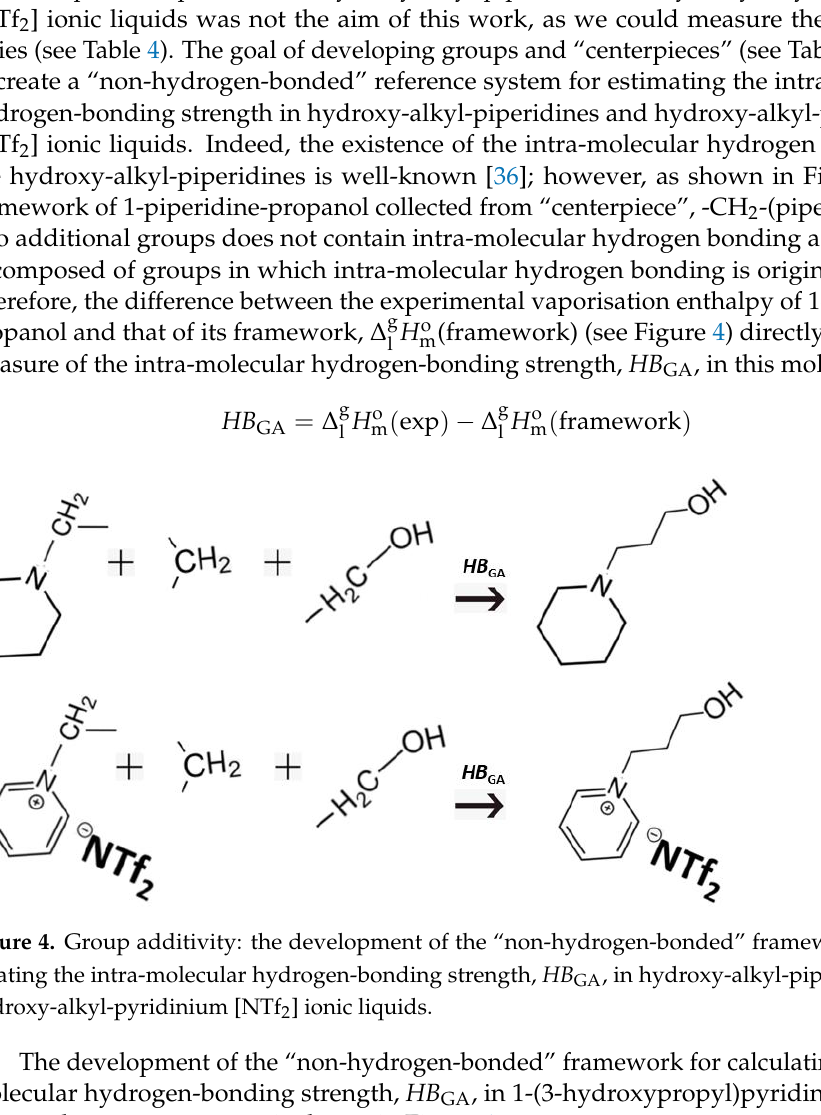
Figure 5. Well-balanced equations: the development of the “non -hydrogen- bonded” reference sys- tems for calculating the intra-molecular hydrogen-bonding strength, HB WBE , in hydroxy-alkyl-pi- peridines and hydroxy-alkyl-pyridinium [NTf 2 ] ionic liquids.